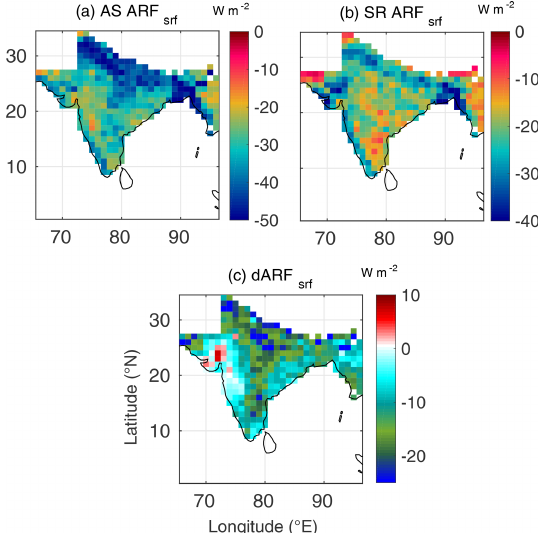
Figure 6. Spatial variation of (a) AS ARF srf (radiative forcing esti- mated using AS AOD and AS SSA, at the surface), (b) SR ARF srf (radiative forcing estimated using SR AOD and SR SSA, at the sur- face) and (c) dARF srf for May 2009.